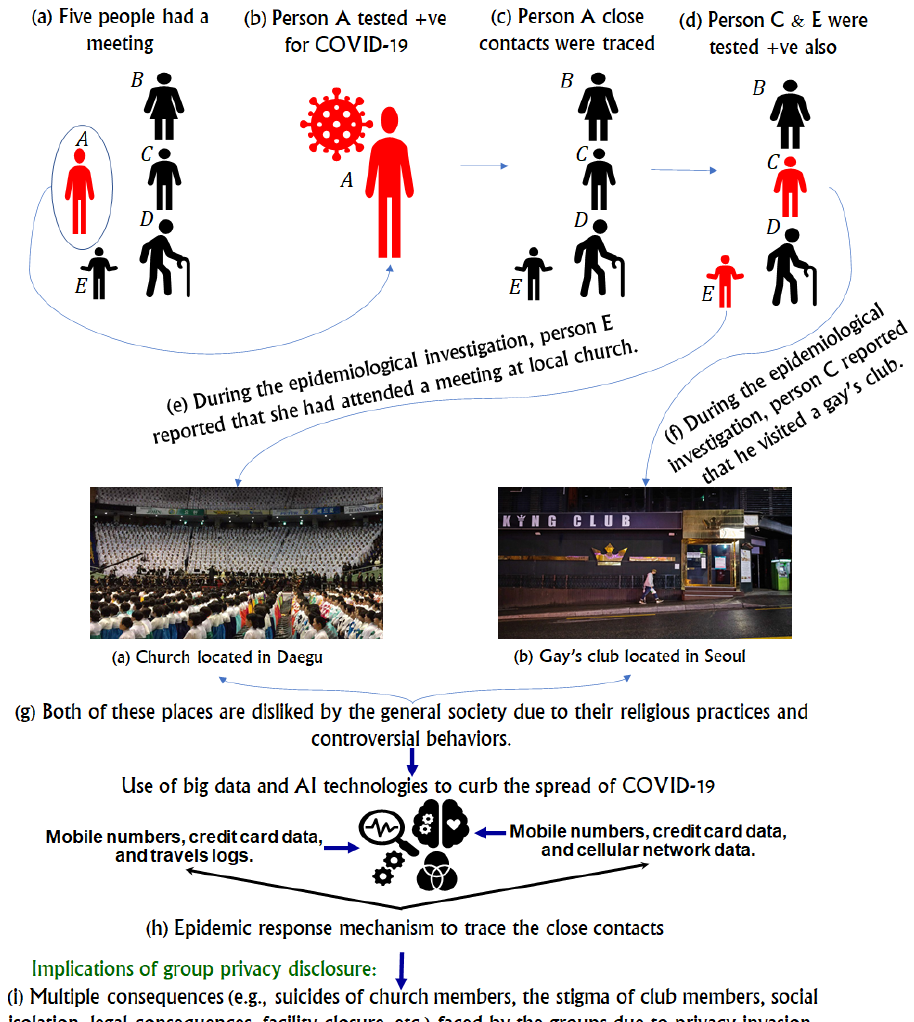
Figure 1. Overview of the emergence of group privacy issues in real-world